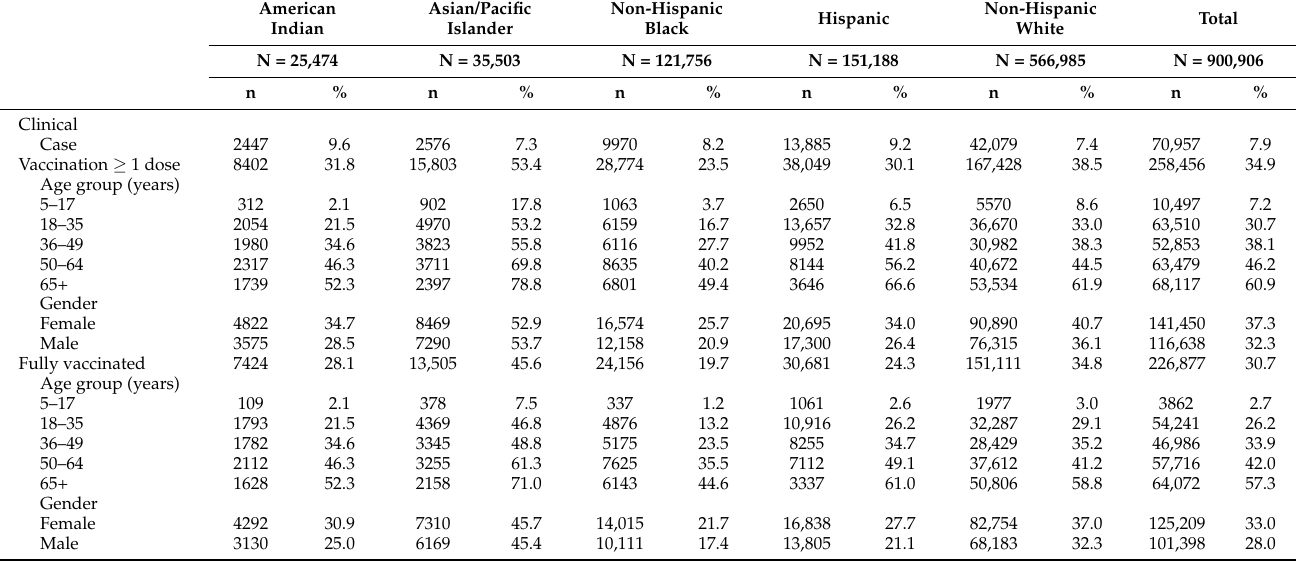
Table 1. The distribution of reported clinical characteristics by population-based race/ethnicity in the population age 5+ years; ≥ 1 dose refers to individuals receiving the first dose of the Pfizer and Moderna COVID-19 vaccines or a single shot of the J&J/Janssen vaccine; fully vaccinated refers to individuals fully vaccinated after receiving either both doses of the Pfizer and/or Moderna COVID-19 vaccines or a single shot of the J&J/Janssen